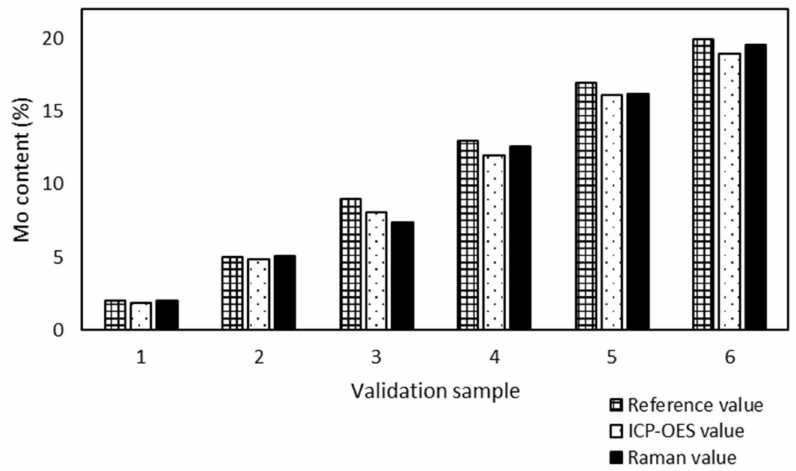
Figure 10. Comparison of ICP-OES and Raman values of Mo content of validation samples supported BEA. The maximum absolute di ff erence is 0.7% (sample 3) and the minimum is 0.1% (sample 1 and